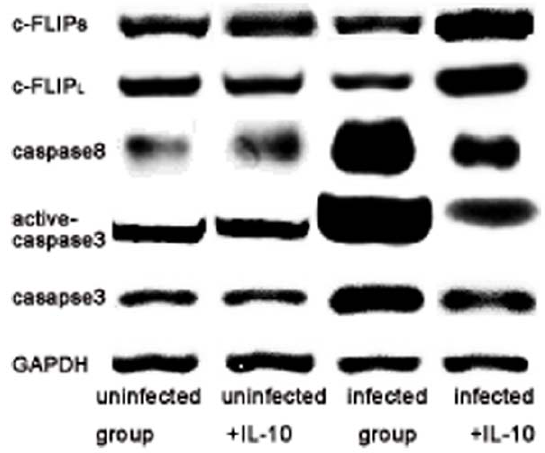
Figure 7. Caspase-3, active caspase-3, caspase-8, active-8, c- FLIP S and c-FLIP L in human trophoblast cells were also analyzed by Western blot. The results showed that caspase-3, active caspase-3 and caspase-8 were up-regulated in infected cells compared to uninfected cells while down-regulated in IL-10 treated cells compared with infected cells (P , 0.05). In this study, levels of active caspase-8 could not be quantified in both infected cells and uninfected cells. In addition, down-regulation of c-FLIP S and c-FLIP L expression occurred in infected cells relative to uninfected cells and up-regulation in IL-10 treated infected cells (P , 0.05). Interestingly, it was also no difference between uninfected cells and IL-10 treated uninfected cells (P . 0.05).